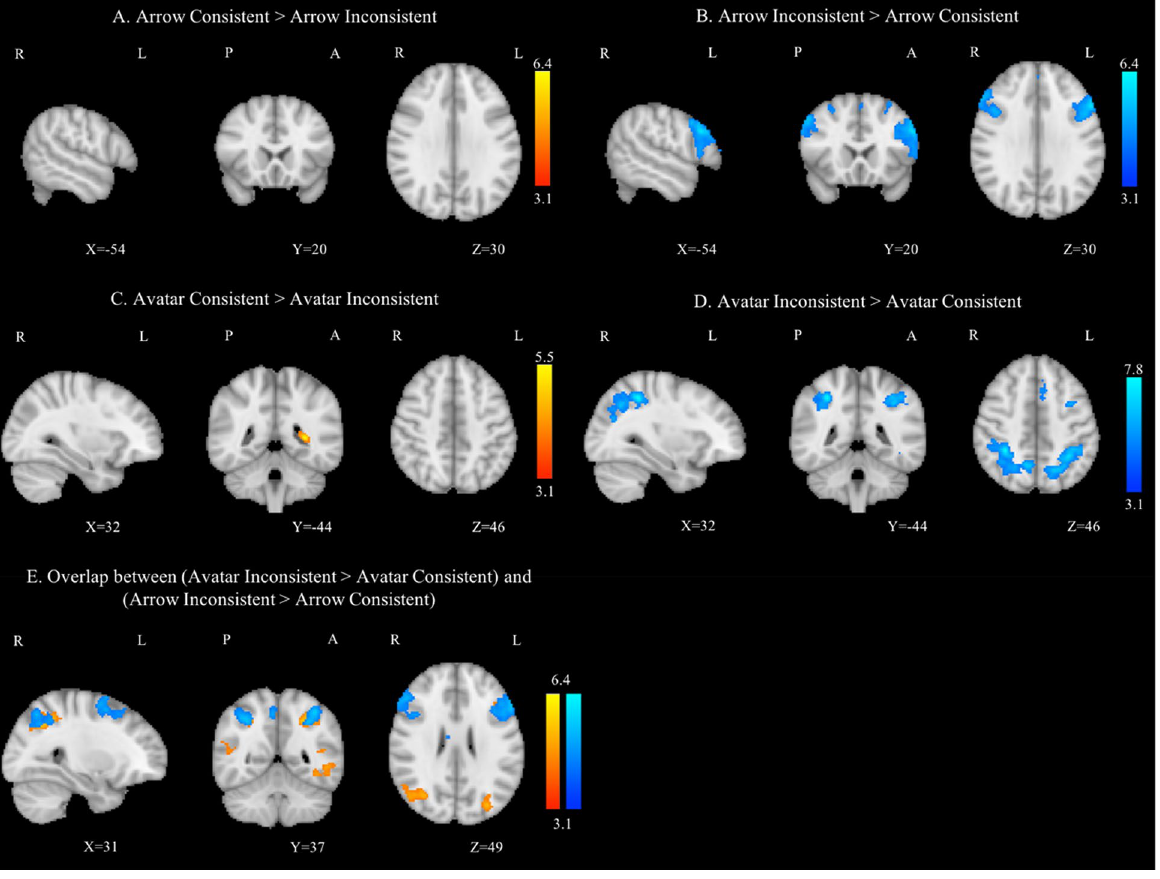
Figure 2. Group average task-related GLM analysis for the contrast Arrow Consistent > Arrow Inconsistent ( A ) and for the inverse comparison Arrow Inconsistent > Arrow Consistent ( B ), for the contrasts Avatar Consistent > Avatar Inconsistent ( C ) and Avatar Inconsistent > Avatar Consistent ( D ), and for the overlap between the contrasts Avatar Inconsistent > Avatar Consistent (in red) and Arrow Inconsistent > Arrow Consistent (in blue) ( E ). Right hemisphere on the left side, all clusters were thresholded by Z > 3.1 and a corrected cluster significance threshold of p =